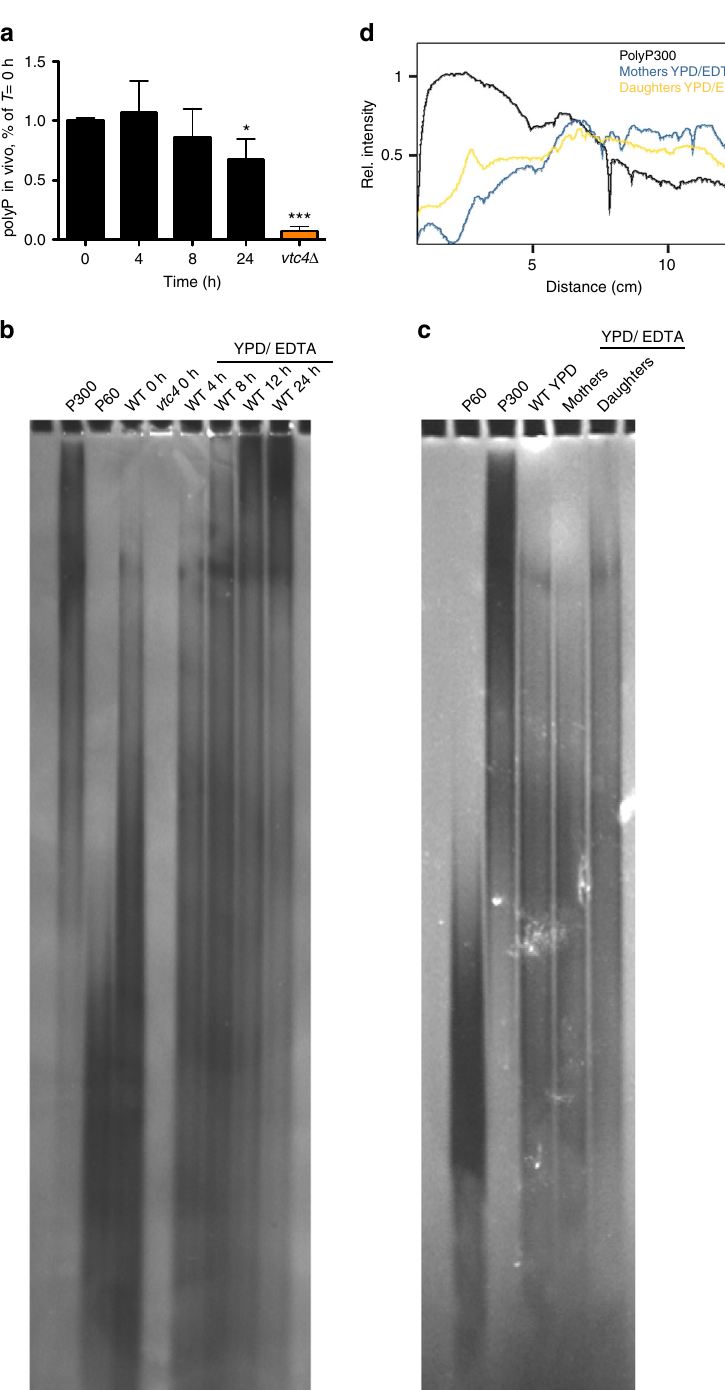
Fig. 2 Amounts and chain length of polyP on YPD/EDTA. a PolyP content in wild-type cells on YPD/EDTA. Cells were grown on YPD/EDTA for the indicated periods of time, collected, and polyP content was assayed. Results represent mean ± SD of three independent experiments. Statistical differences were determined using Student ’ s t test comparing polyP levels from T = 0 h with the later time points and the vtc4 Δ strain; * p ≤ 0.05; *** p ≤ 0.001. b Chain length. PolyP was extracted from cells growing on YPD/EDTA for the indicated periods of time. PolyP was puri fi ed from cells by glass bead rupture and phenol/chloroform extraction. Samples were treated with RNAse A and proteinase K before 30 nmol of polyP were resolved on a 15% polyacrylamide gel, followed by negative staining with DAPI. c Mother (m) and daughter (d) fractions were separated after 16 h of growth on YPD/EDTA. PolyP was extracted from cells as in ( b ), resolved on a 20% polyacrylamide gel and stained with DAPI. PolyP isolated from a non-separated population of wild-type cells growing logarithmically on YPD is shown for comparison. d The signal intensity in the lanes with mother and daughter samples from ( c ) was quanti fi ed using ImageJ, starting at the top of the gel. The pro fi le for polyP300 was included for